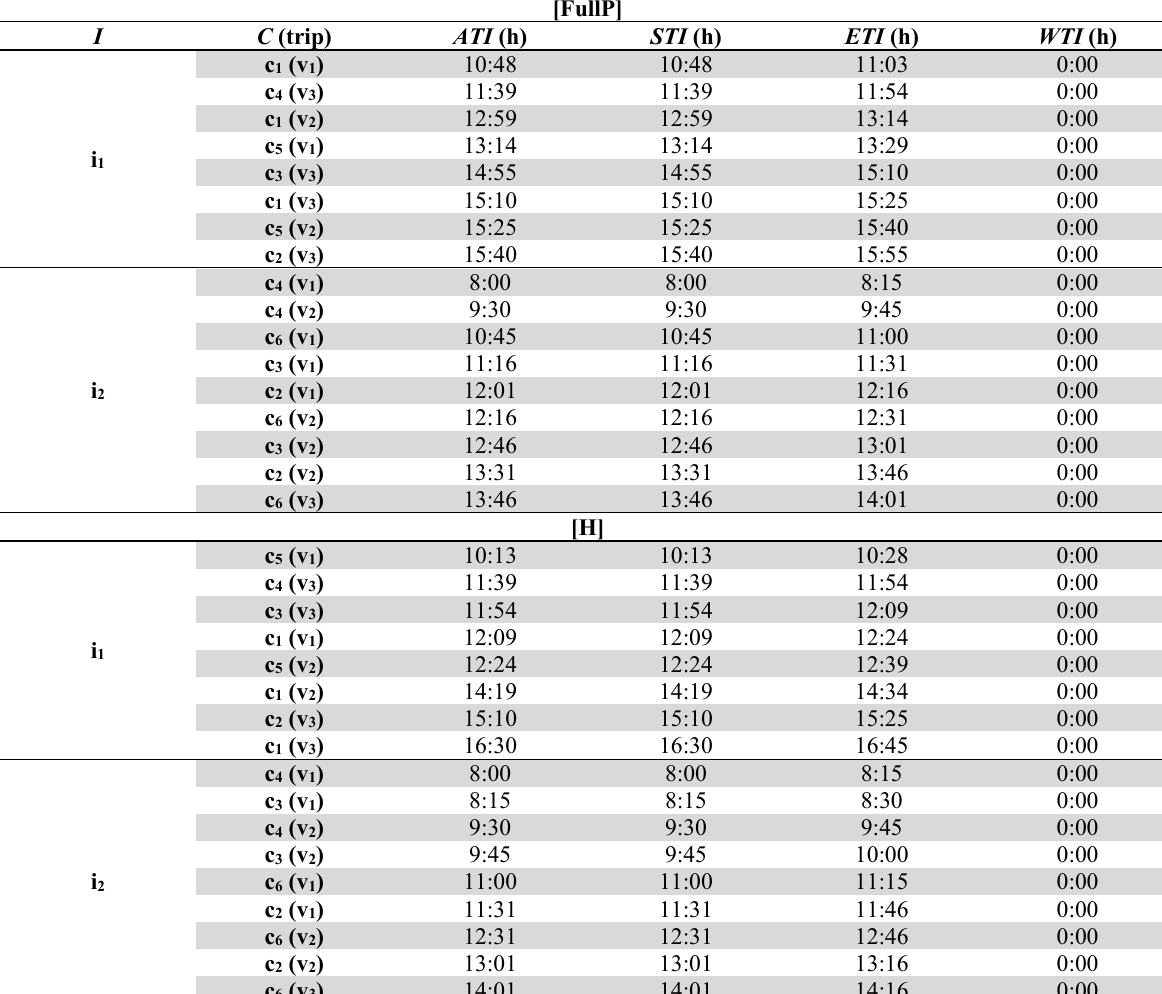
Table 7 Unloading scheduling in the